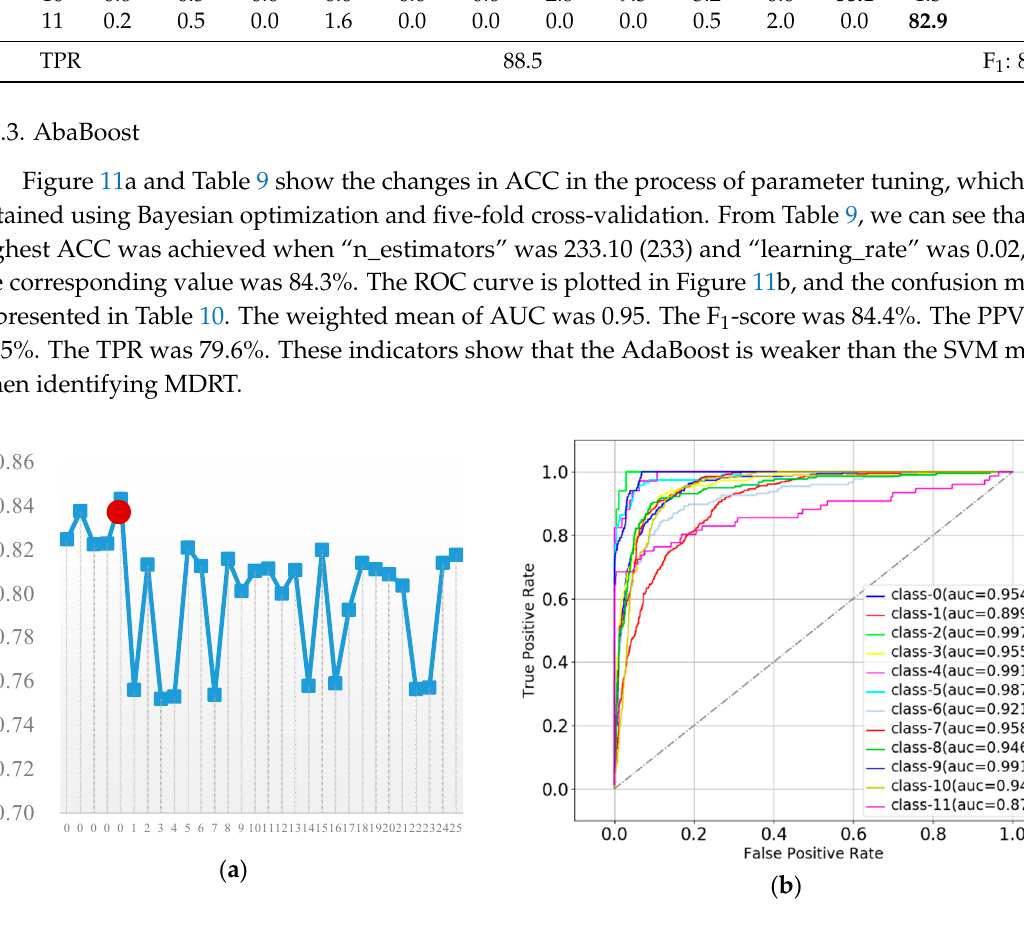
Figure 11. Parameter Tuning Process and ROC of AdaBoost, where ( a ) Description of the parameter tuning process of AdaBoost, where y -axis is ACC and x -axis is iteration; ( b ) ROC of AdaBoost. Table 9. Parameter Tuning Process of AdaBoost Classifier.